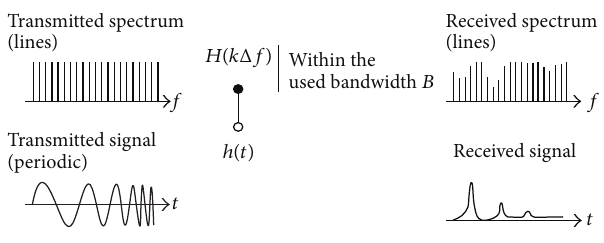
Figure 2: Channel sounding principle [17].